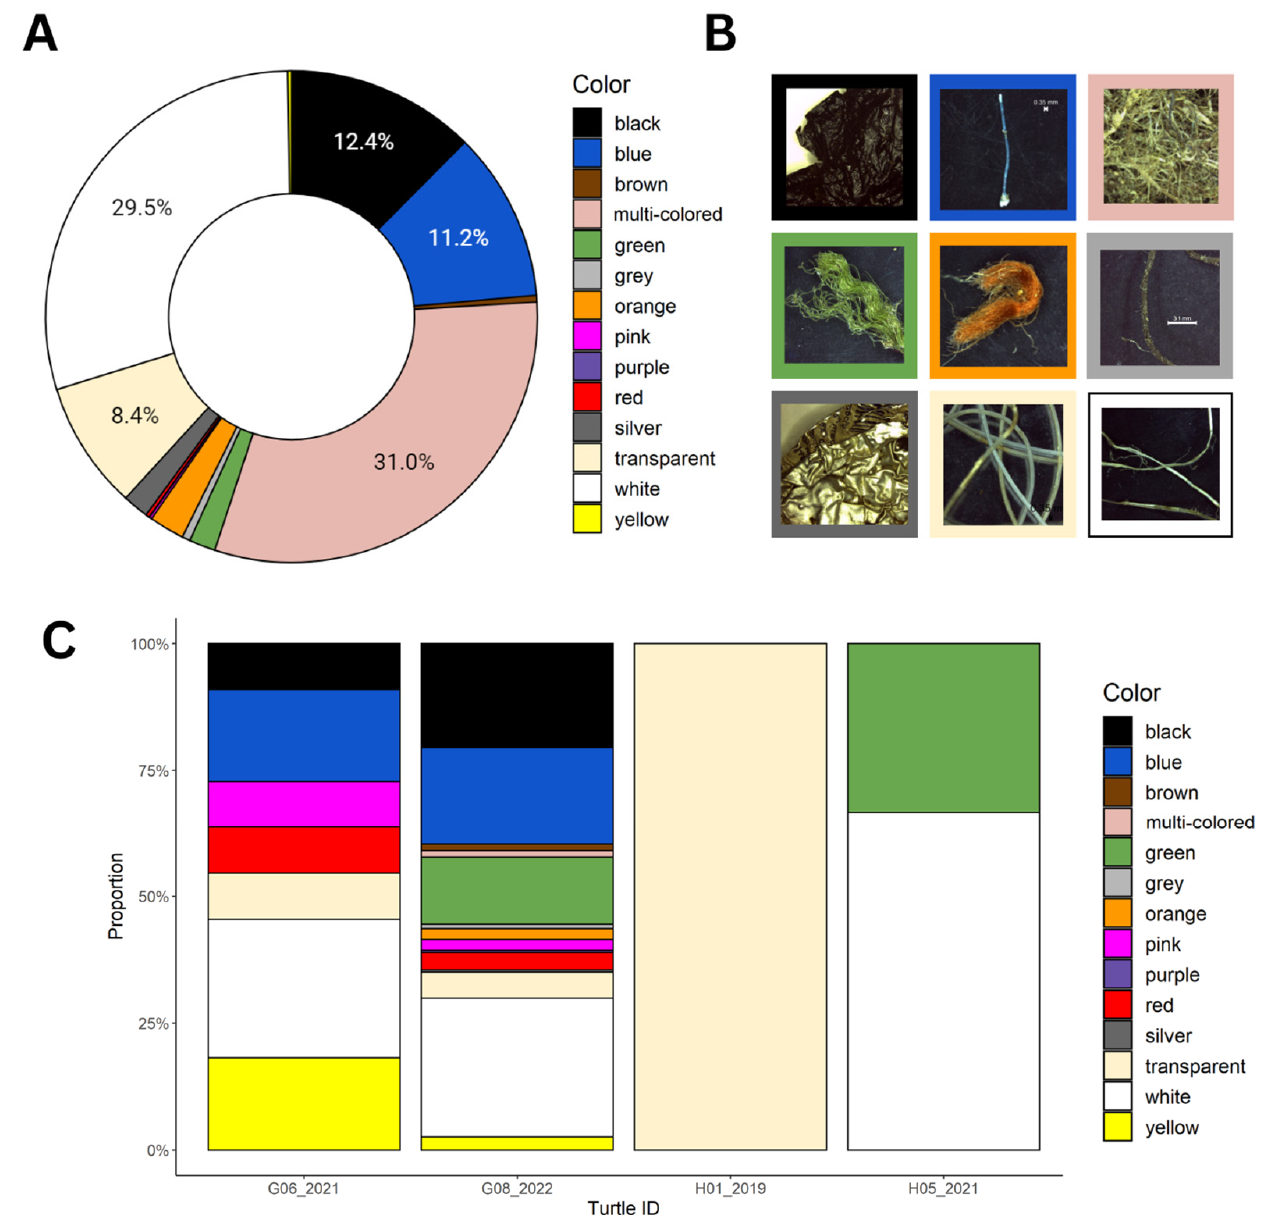
Figure 3. ( A ) The proportion of the colors of plastic found by mass in the digestive tracts of the turtles in the Saudi Arabian Red Sea. ( B ) Photographs displaying examples of the most common colors of plastic found in the gastrointestinal contents of turtles in this study. ( C ) The proportion of each color of plastic found in the digestive tracts of the four deceased sea turtles.